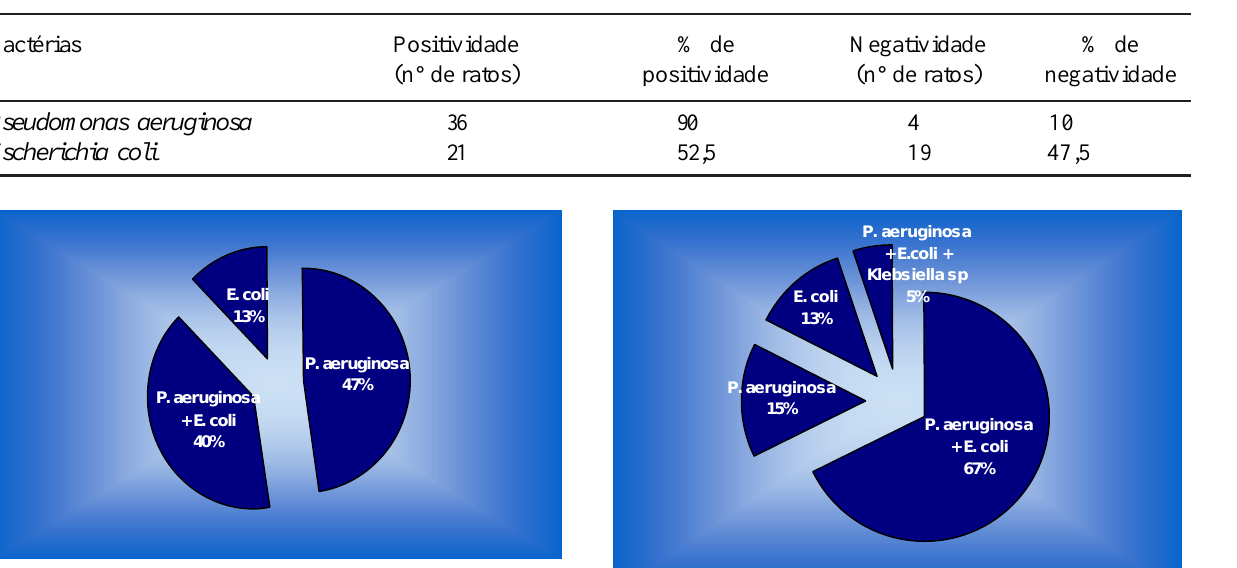
FIGURA 2 - Resultado da hemocultura positiva para Pseudomonas aeruginosa, E. coli ou ambas as bactérias em percentual de positividade.